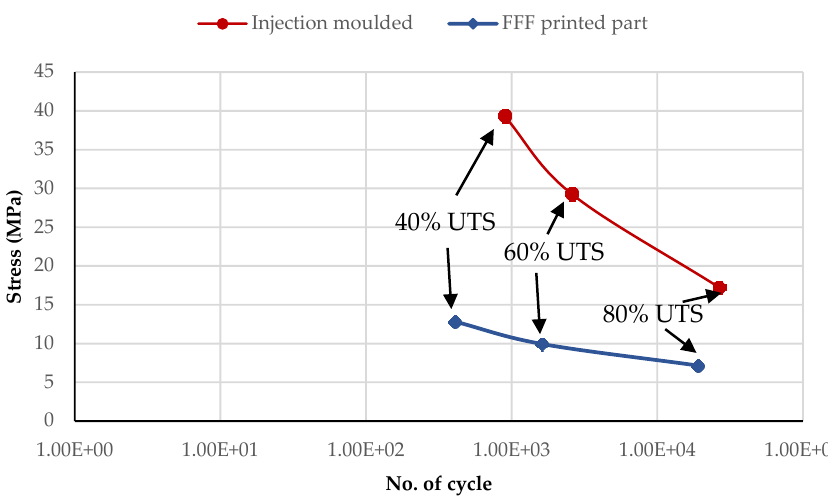
Figure 2. S–N curve for 3D-printed and injection-moulded ABS specimens (Adapted from S-N curves Figure 2. S – N curve for 3D-printed and injection-moulded ABS specimens (Adapted from S-N by Padzi et al. [15]. CC BY curves by Padzi et al. [15]. CC BY 3.0).